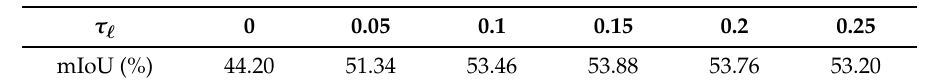
Table 3. Influence of τ (cid:96) . The hyper-parameter τ (cid:96) balances the foreground and background pixels when generating low GradCAM D proposals. τ (cid:96) = 0 means all pixels within boxes annotations are seen as proposals.